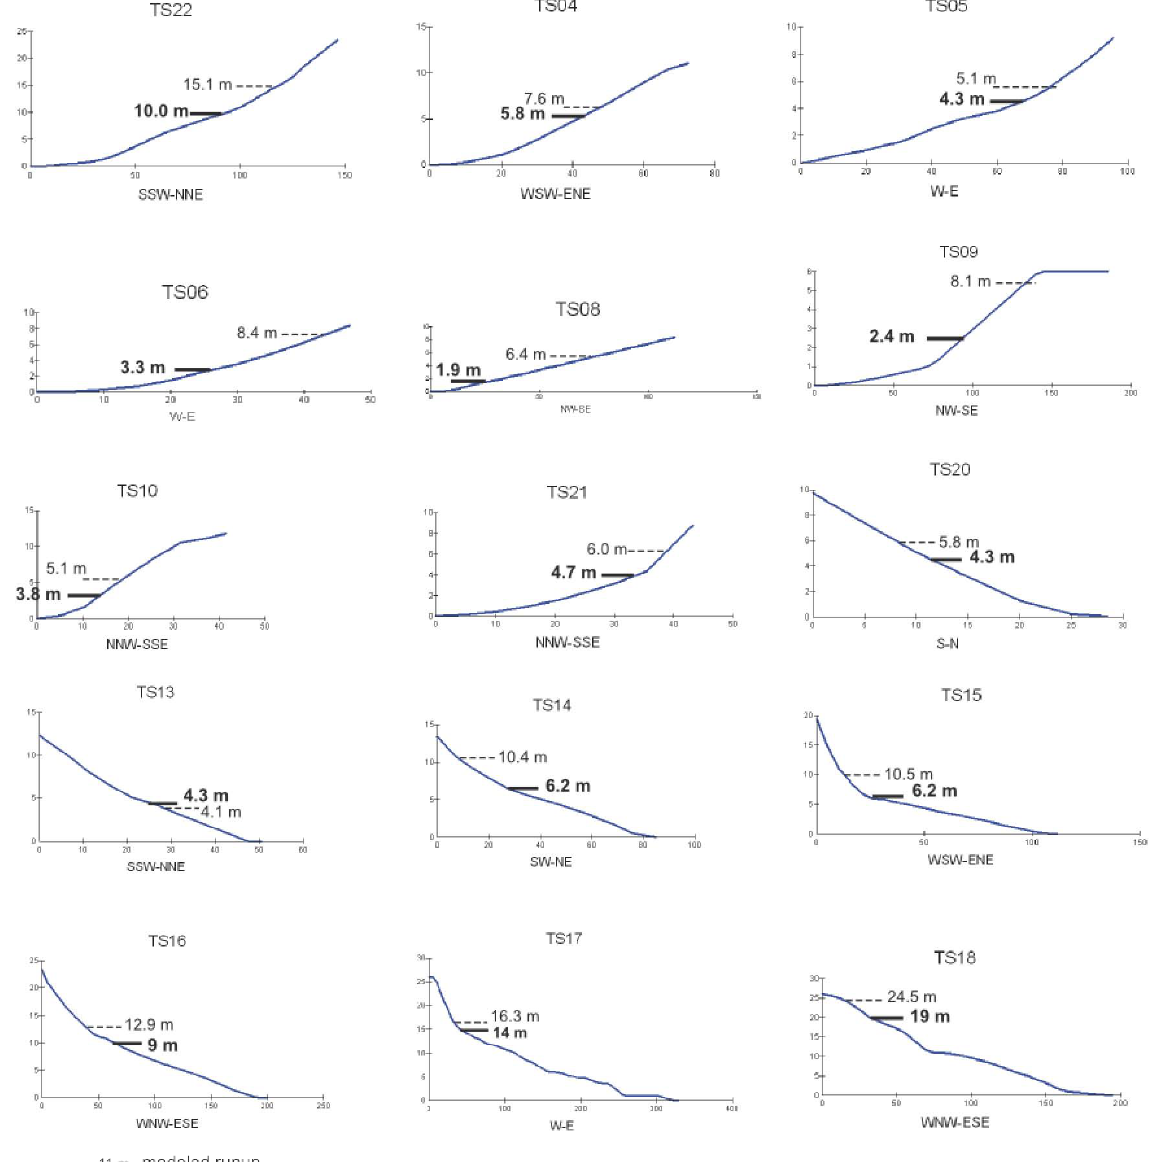
Fig. 10. Beach profiles, runup measurements, and modeled runup